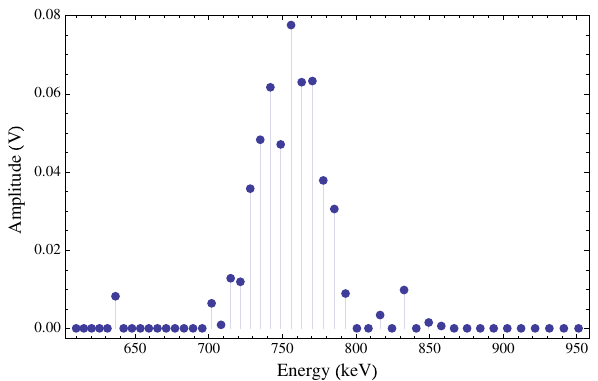
FIG. 27. Energy spectrum of the H − beam after the RFQ modifications. The energy of this spectrum is ð 756 . 5 (cid:1) 0 . 5 Þ keV with the dipole current at 7.5 A.